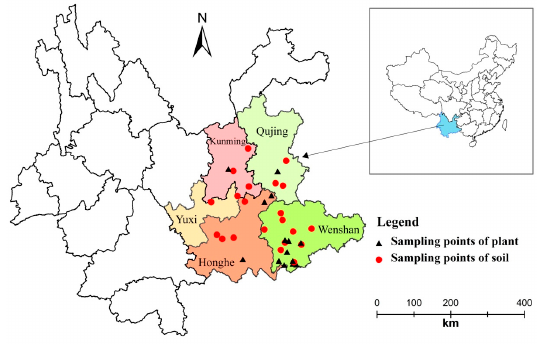
Figure 1. Sampling points of soils and plants (created by the ArcGIS 10.2 program).